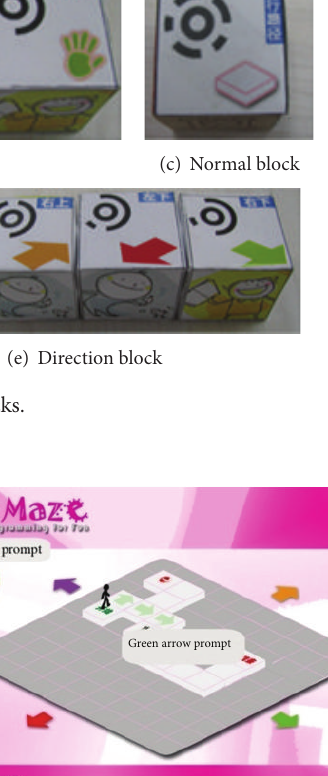
of the occupied square will change into a green